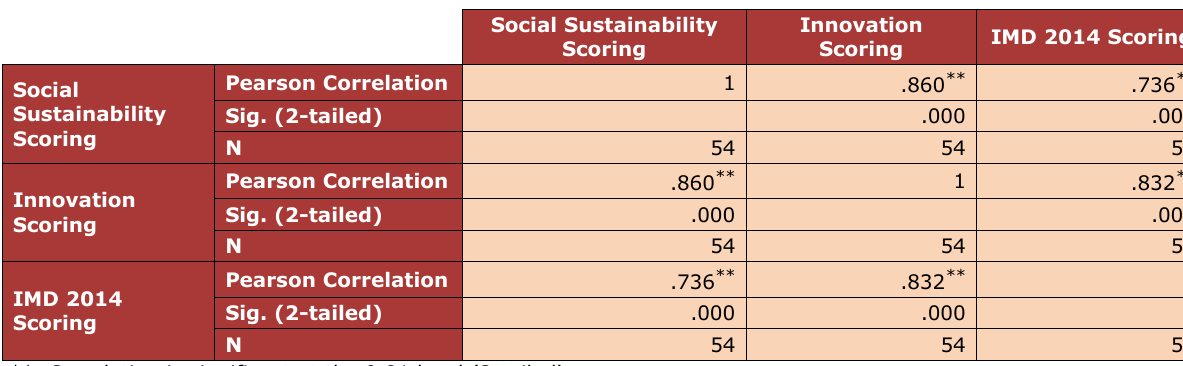
Table 2. Pearson correlation coefficient between Social Sustainability Scoring, Innovation Scoring, and